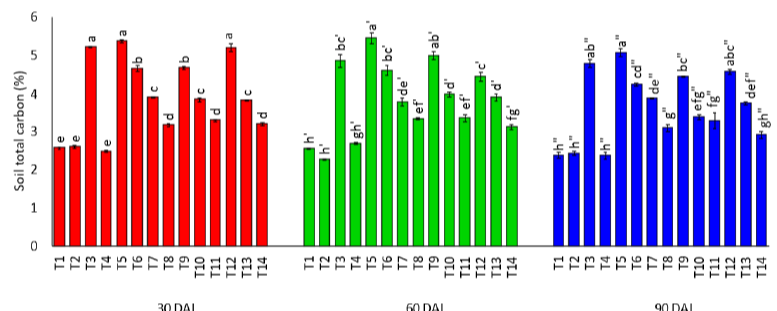
Figure 2. Effects of treatments on soil total carbon after thirty, sixty, and ninety days of incubation, where T1: soil alone, T2: Egypt rock phosphate alone, T3: Egypt rock phosphate + 100% charcoal, T4: Egypt rock phosphate + 100% sago bark ash, and T5: Egypt rock phosphate + 100% charcoal + 100% sago bark ash, T6: Egypt rock phosphate + 75% charcoal + 75% sago bark ash, T7: Egypt rock phosphate + 50% charcoal + 75% sago bark ash, T8: Egypt rock phosphate + 25% charcoal + 75% sago bark ash, T9: Egypt rock phosphate + 75% charcoal + 50% sago bark ash, T10: Egypt rock phosphate + 50% charcoal + 50% sago bark ash, T11: Egypt rock phosphate + 25% charcoal + 50% sago bark ash, T12: Egypt rock phosphate + 75% charcoal + 25% sago bark ash, T13: Egypt rock phosphate + 50% charcoal + 25% sago bark ash, and T14: Egypt rock phosphate + 25% charcoal + 25% sago bark ash. Means with different letter(s) within the same incubation period indicate significant differences between treatments according to Tukey’s HSD test at p ≤ 0.05, i.e., a > b > c. Bars represent the mean values ±